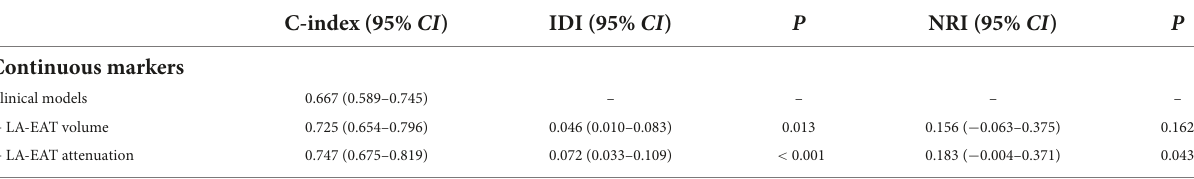
TABLE 6 Discrimination accuracy and reclassification of risk markers of